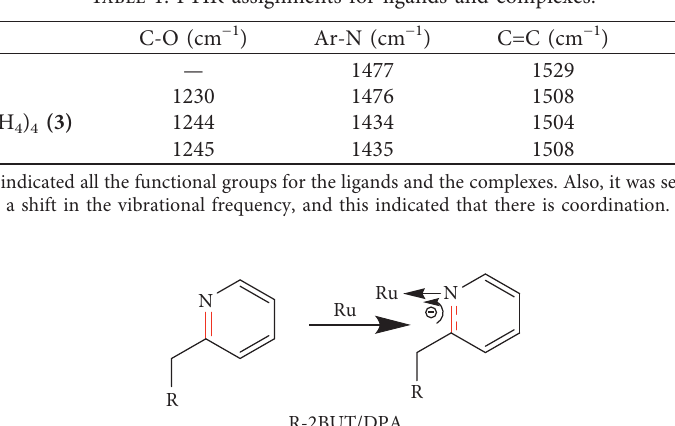
Figure 2: Ruthenium pulling electrons from the pyridyl nitrogen, therefore, reducing the electron density of the C � N bond together with the vibrational frequency of this bond as per Hooke’s law. Table 2: Complexes and their associated electronic spectroscopy bands.